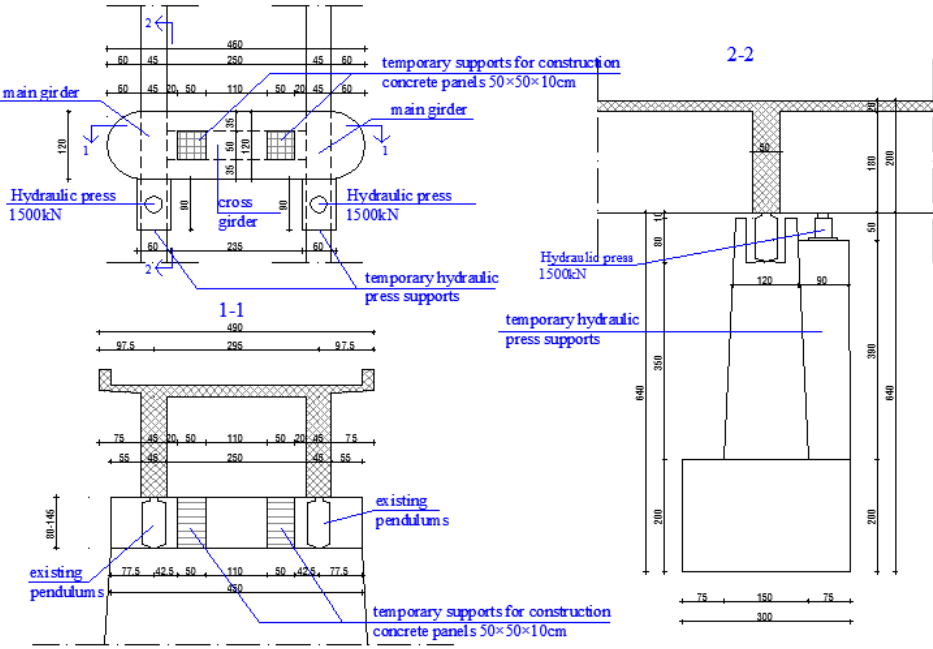
Figure 22. The disposition of constructed system for deck structure raising.